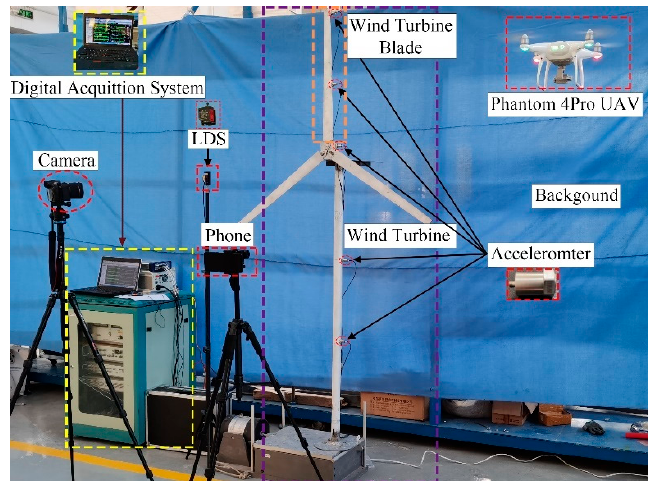
Figure 20. Experimental equipment.